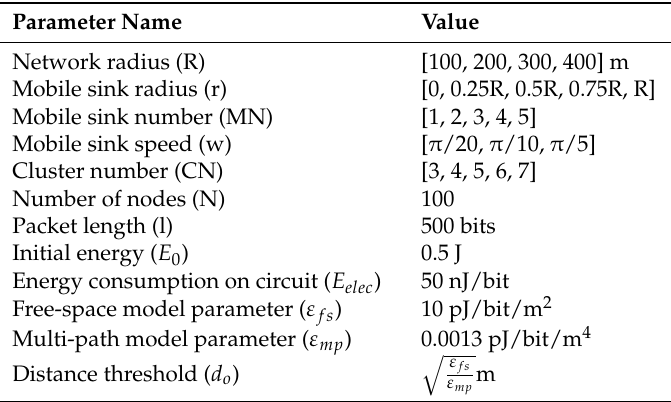
Table 1. Simulation